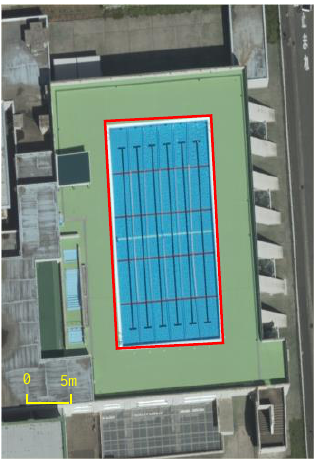
Figure2. Study area of a swimming pool as an artificial pool